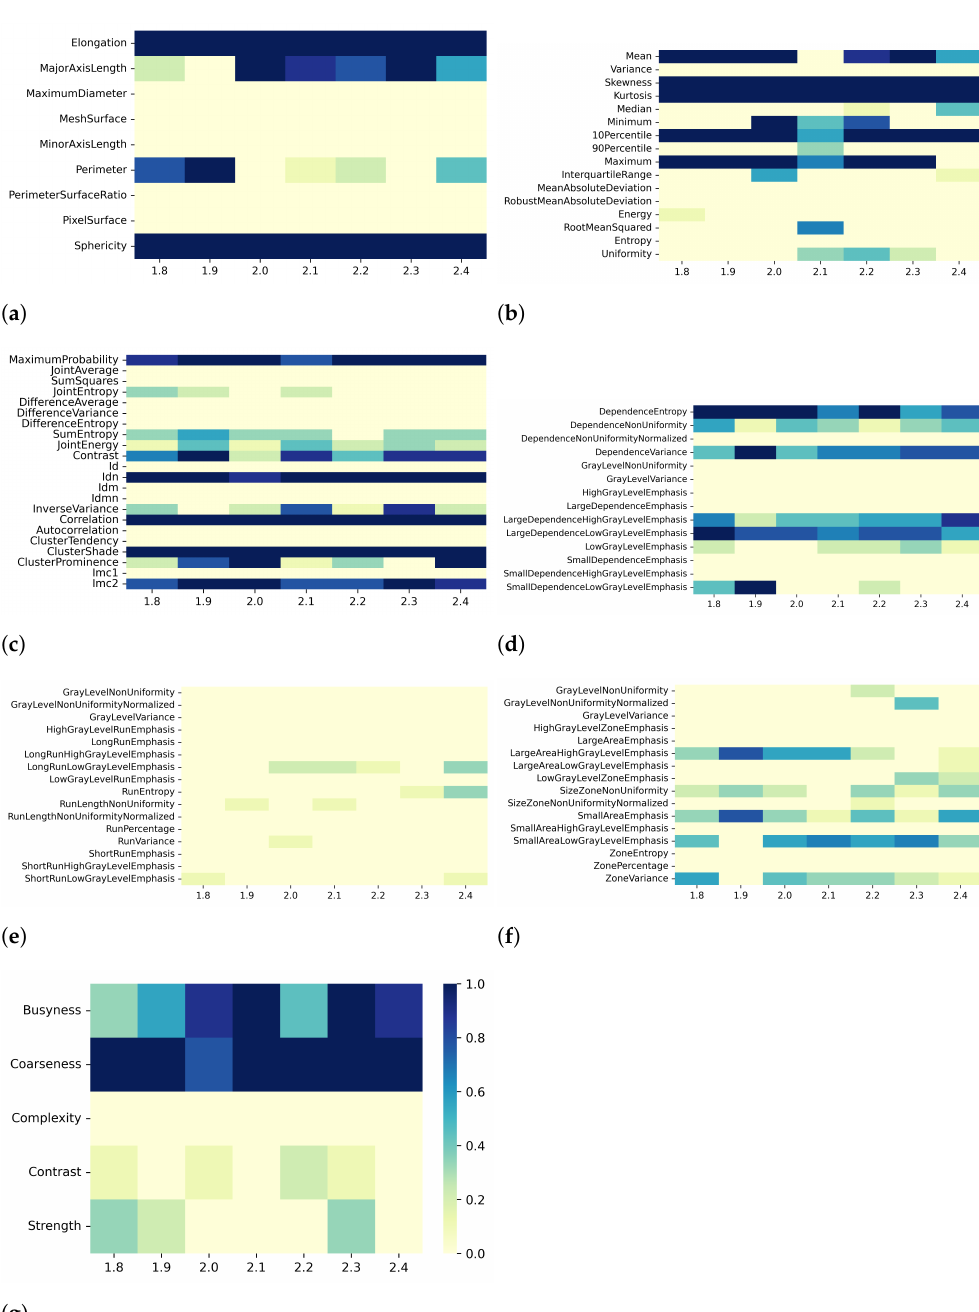
Figure 4. Heatmaps of remaining features from T1 maps after PCC-based dimensionality reduction for effect B (varying discretization bin width, with fixed resampling voxel size (mm)). The radiomic features are separated in classes: ( a ) 2D shape, ( b ) first order, ( c ) GLCM, ( d ) GLDM, ( e ) GLRLM, ( f ) GLSZM, ( g )